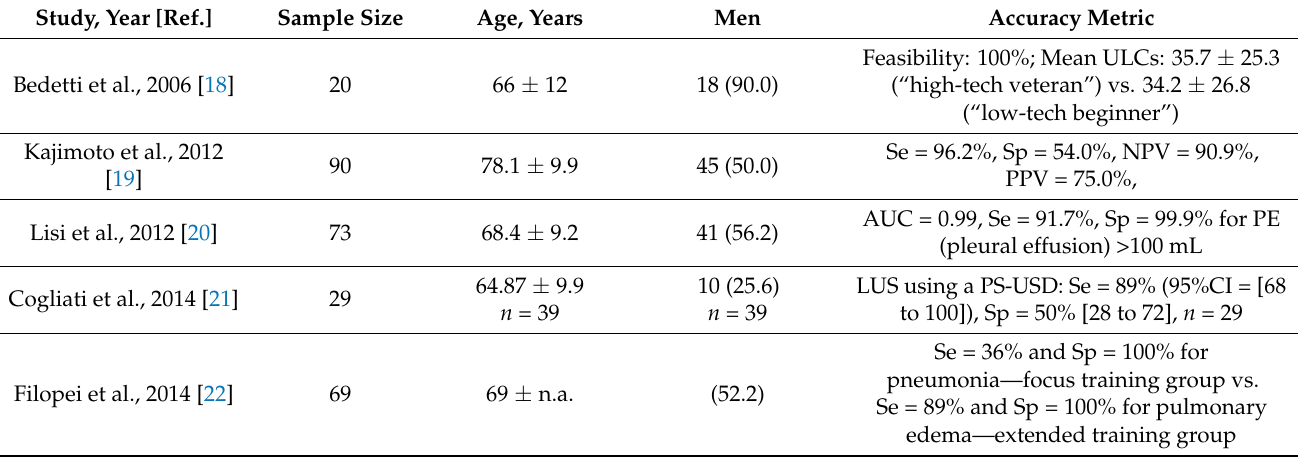
Table 2. Demographics of the evaluated subjects and reported accuracy